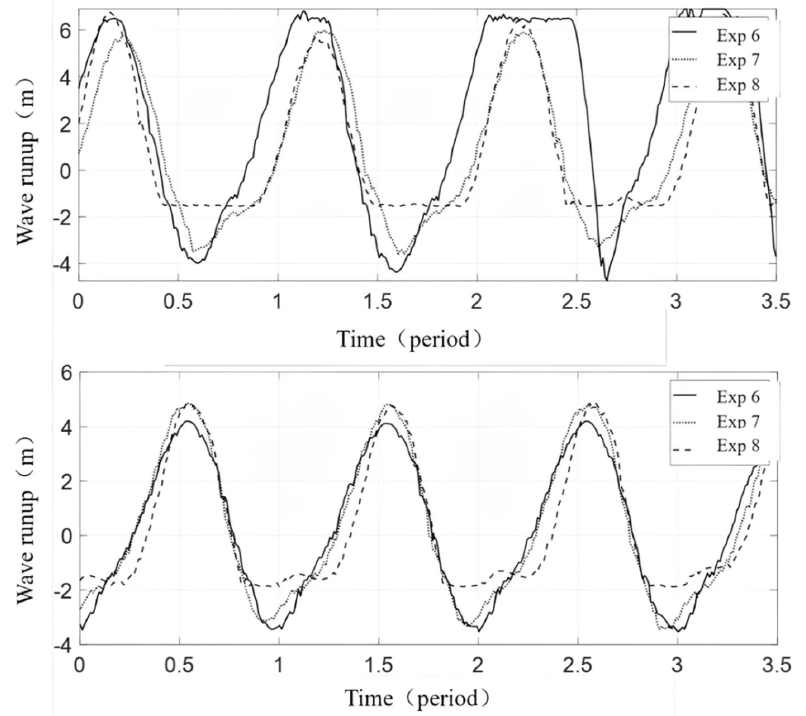
Figure 13. Wave run-up at Dazuo Seawall for Exp 6–8 of typhoons Usagi ( upper ) and Dujuan ( lower